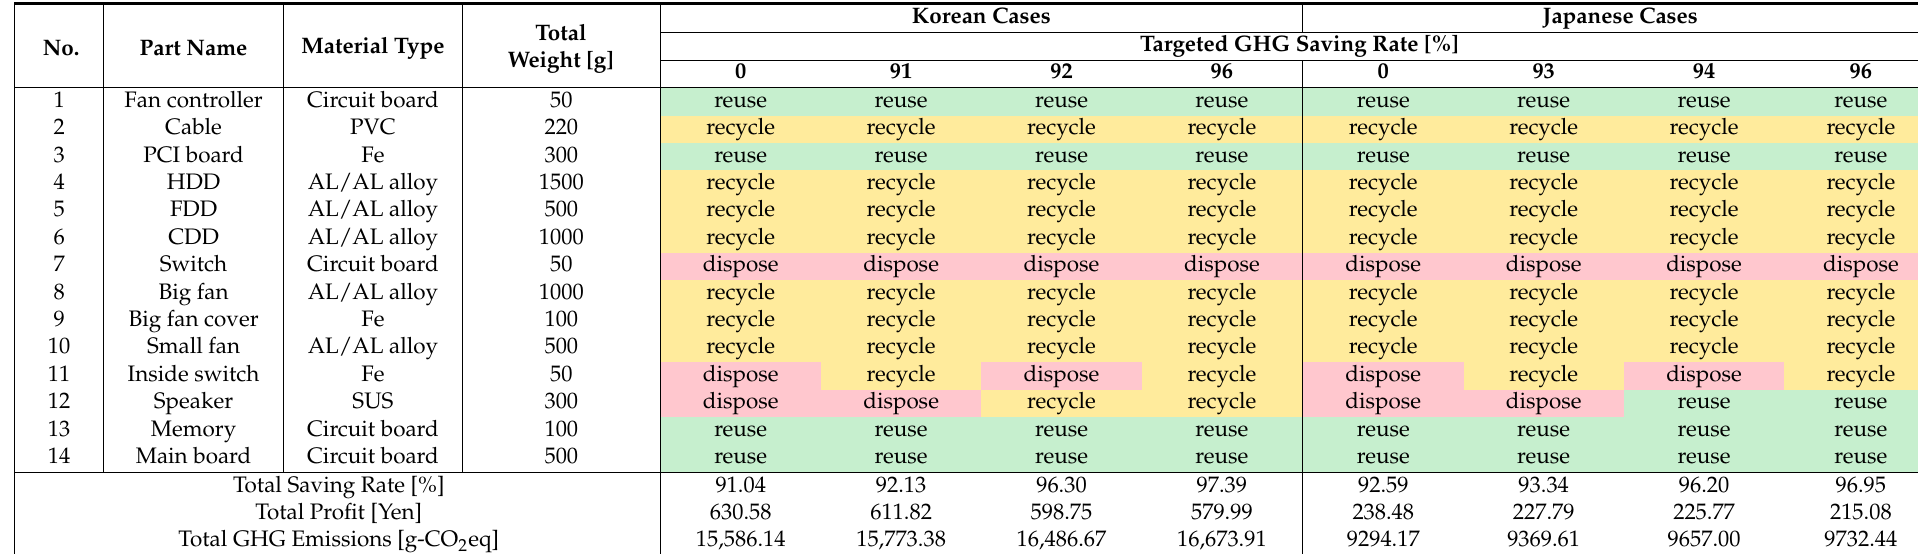
Table 3. The results of life cycle option selection on Korea and Japan: five usage-years